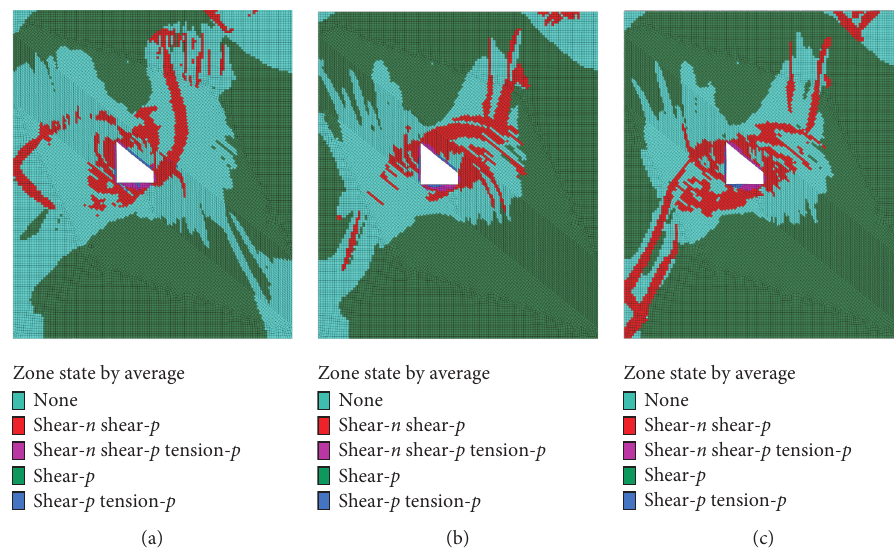
Figure 10: Distribution of the plastic zones in the rock surrounding the roadway. (a) No support. (b) Original support. (c) New combined support.